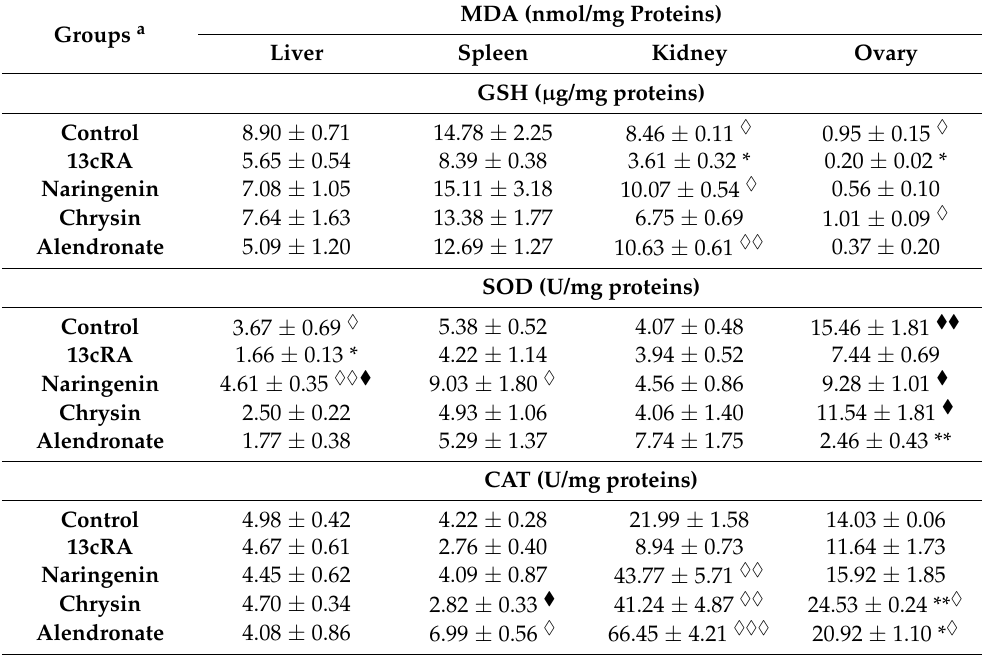
Table 4. Cont. Groups